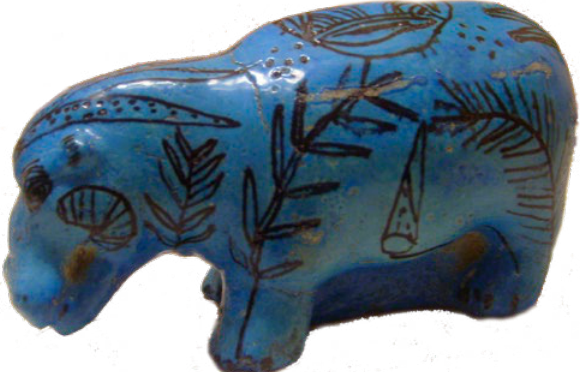
Figure 7. Hippo Goddess (Taweret, goddess of childbirth) in blue faience.